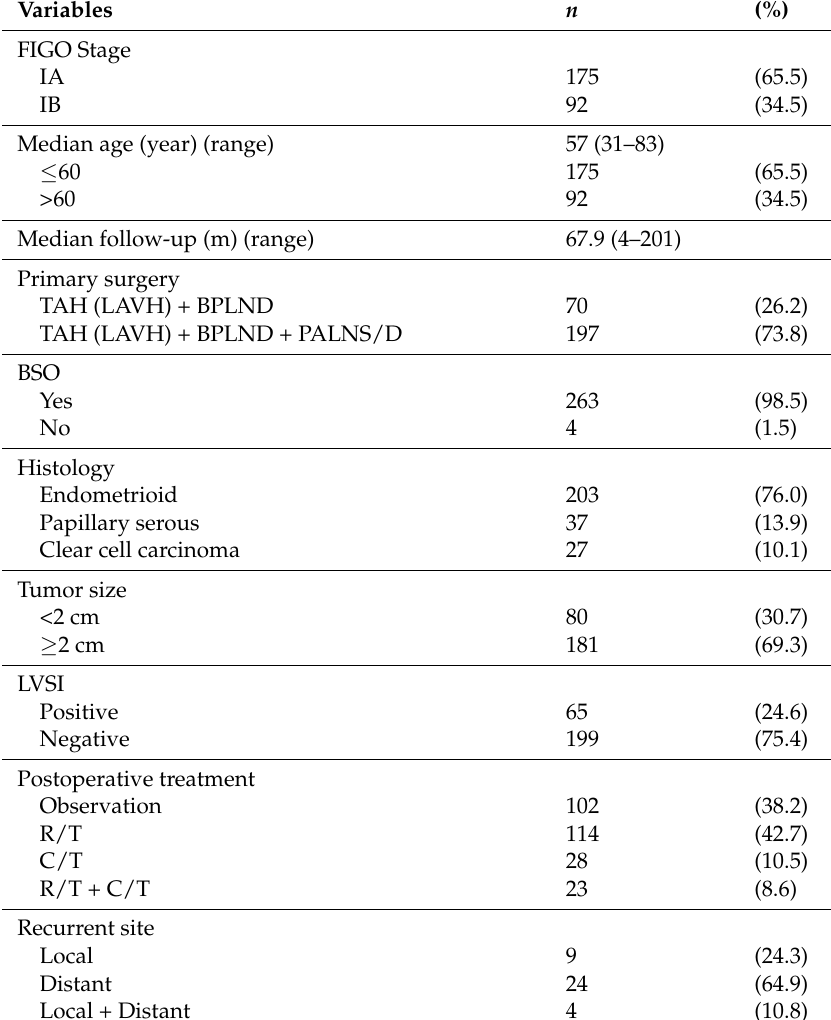
Table 1. Clinicopathologic features of patients ( n = 267).